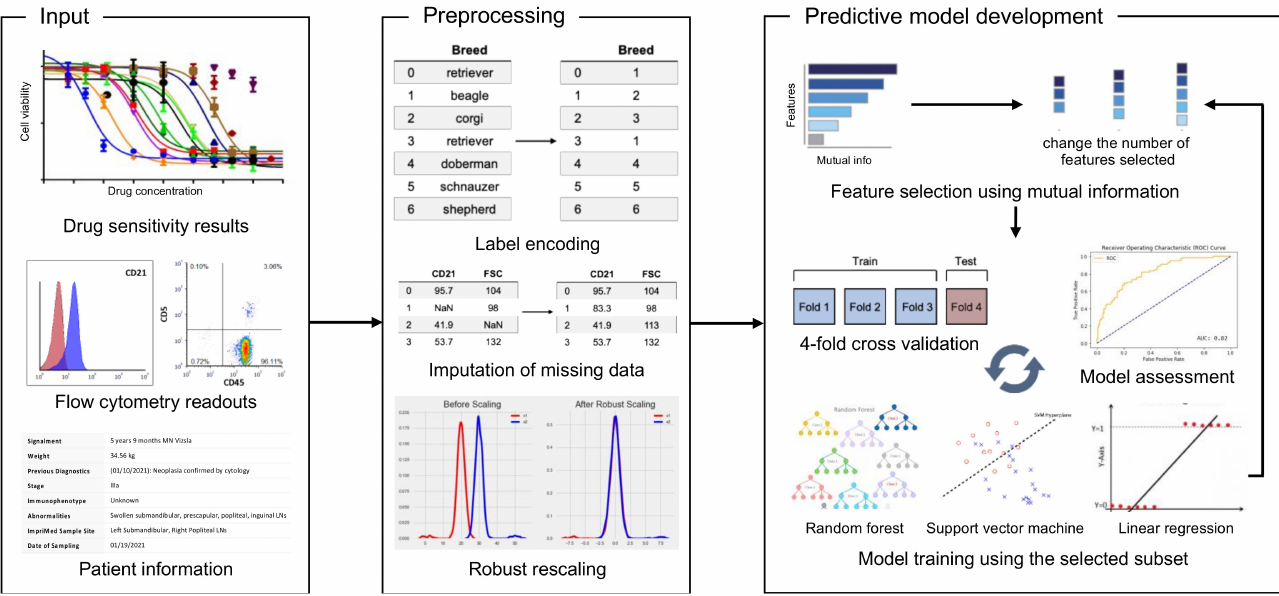
Figure 1. The three types of data used in the ML models and schematic overview of the proposed methodology for predicting dynamic clinical outcomes of canine lymphoma patients treated with (L-)CHOP